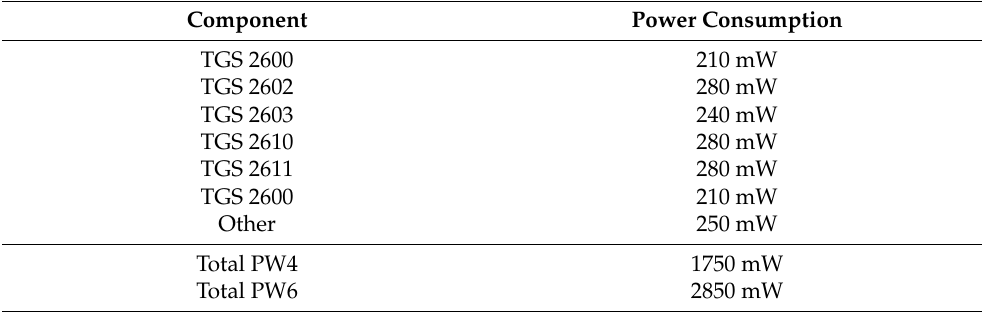
Table 3. Power consumption of sensors’ heaters and other electronic components used in PW4 and PW6 electronic